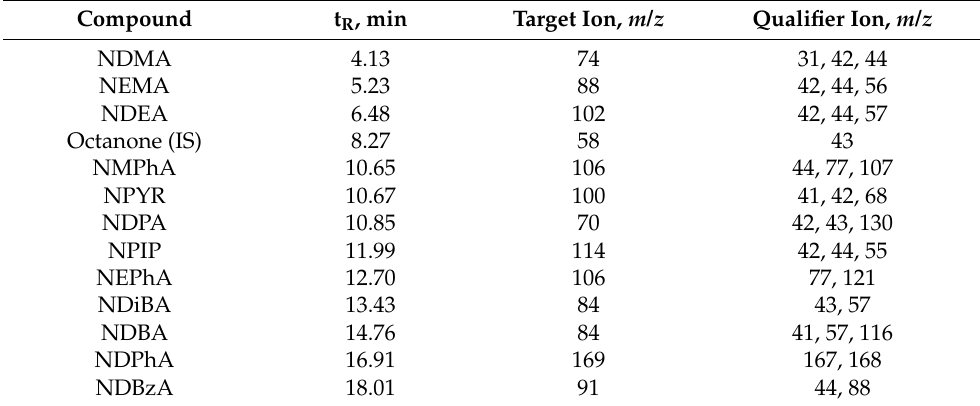
Table 1. Chromatographic and detection parameters for analysis of